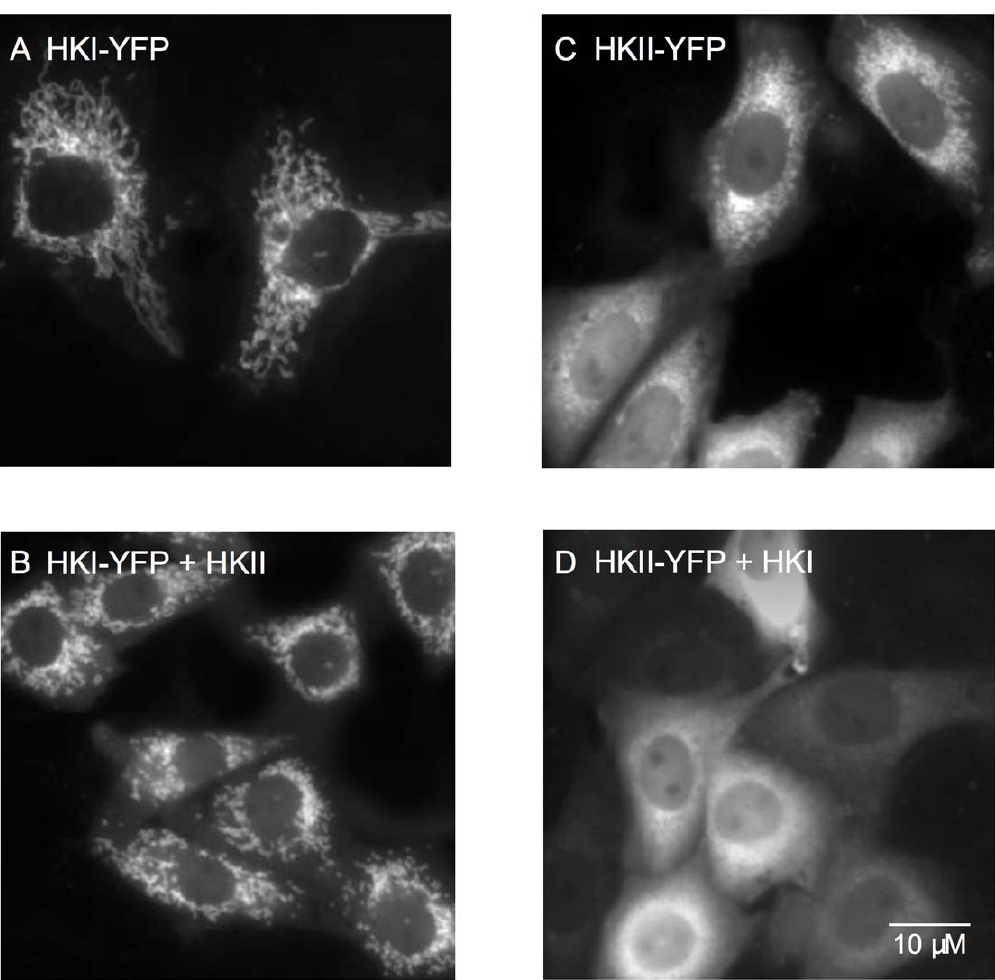
Figure 1. Subcellular distribution of HKI and HKII linked to YFP in CHO cells. In the left panel HKI-YFP is expressed alone (A) or with HKII (B) (ratio 1:3). In this case HKI-YFP is bound to mitochondria and is not displaced by overexpressed HKII. In the right panel HKII-YFP is expressed alone and shows a mixed distribution between mitochondria and cytosol (C). In this case overexpression of HKI with HKII-YFP (ratio 1:3) prevents HKII-YFP interaction with mitochondria (D). Similar subcellular distribution of HKI-YFP and HKII-YFP was observed in HEK293